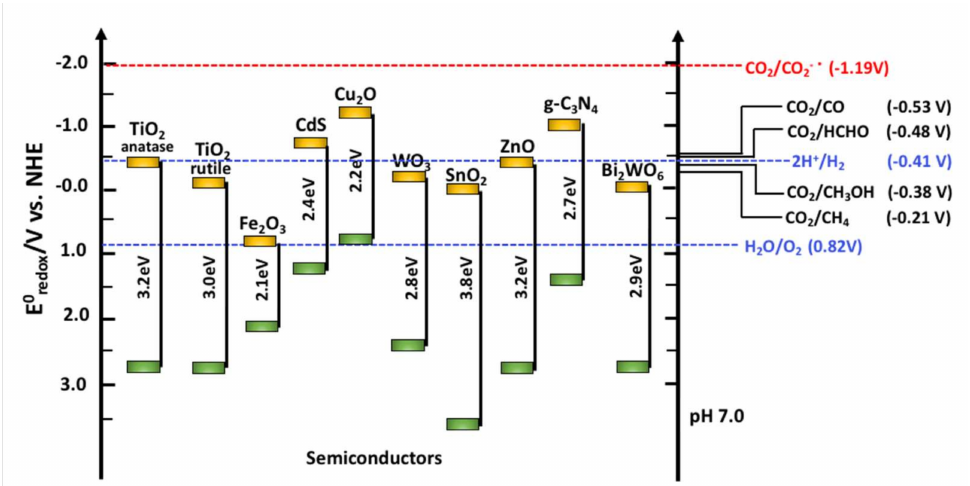
Figure 5. The bandgap of some photocatalysts concerning the redox potential of different chemical species, measurements conducted at a pH of 7. Adapted with permission from Ref. [68]. Copyright 2015